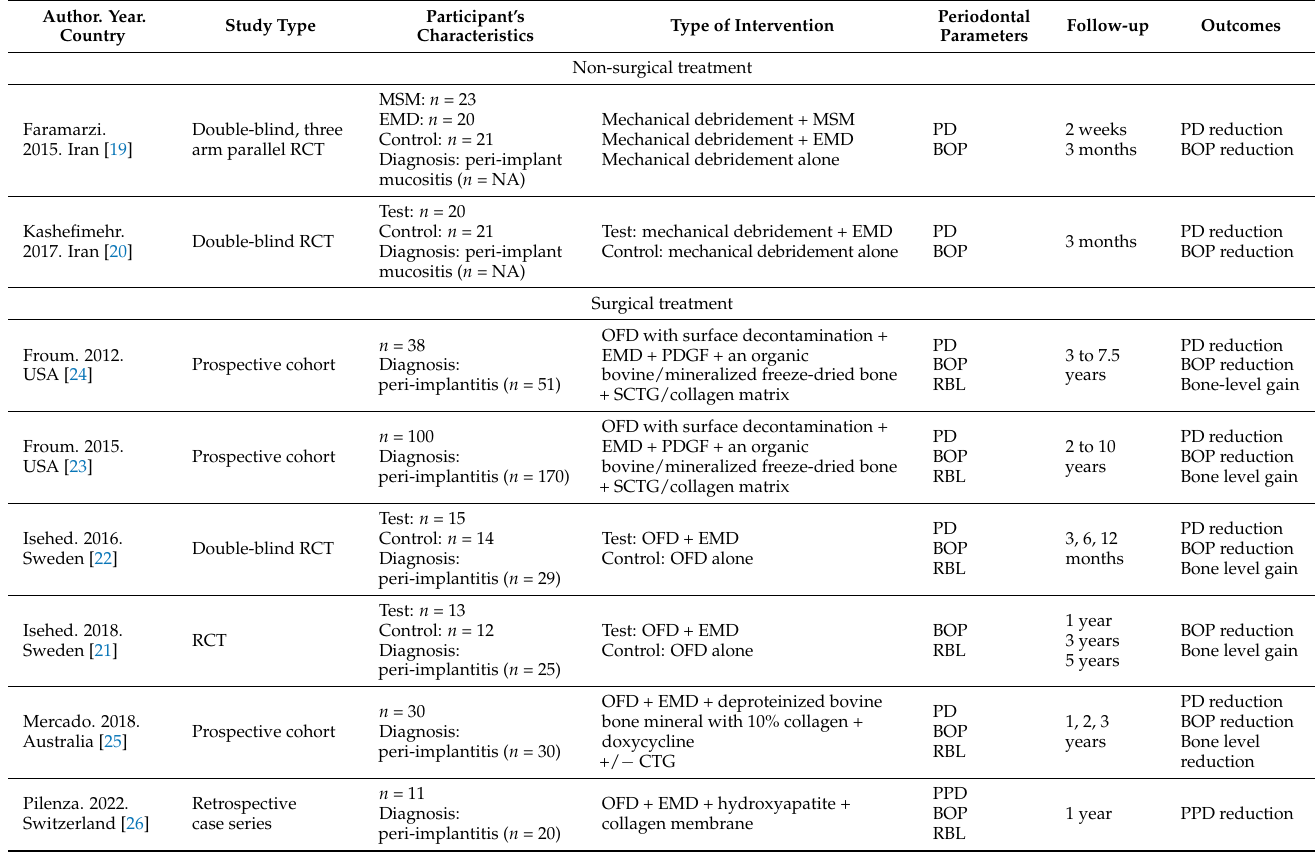
Table 1. Characteristics of the included